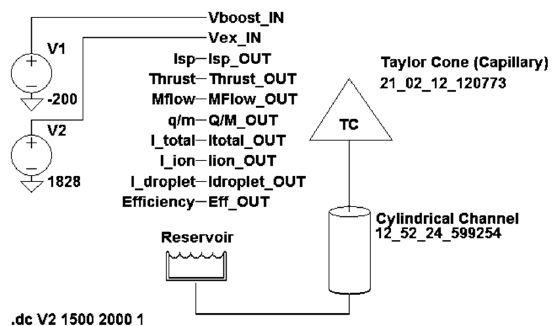
Figure 7. Single capillary emitter thruster schematic in LTspice.